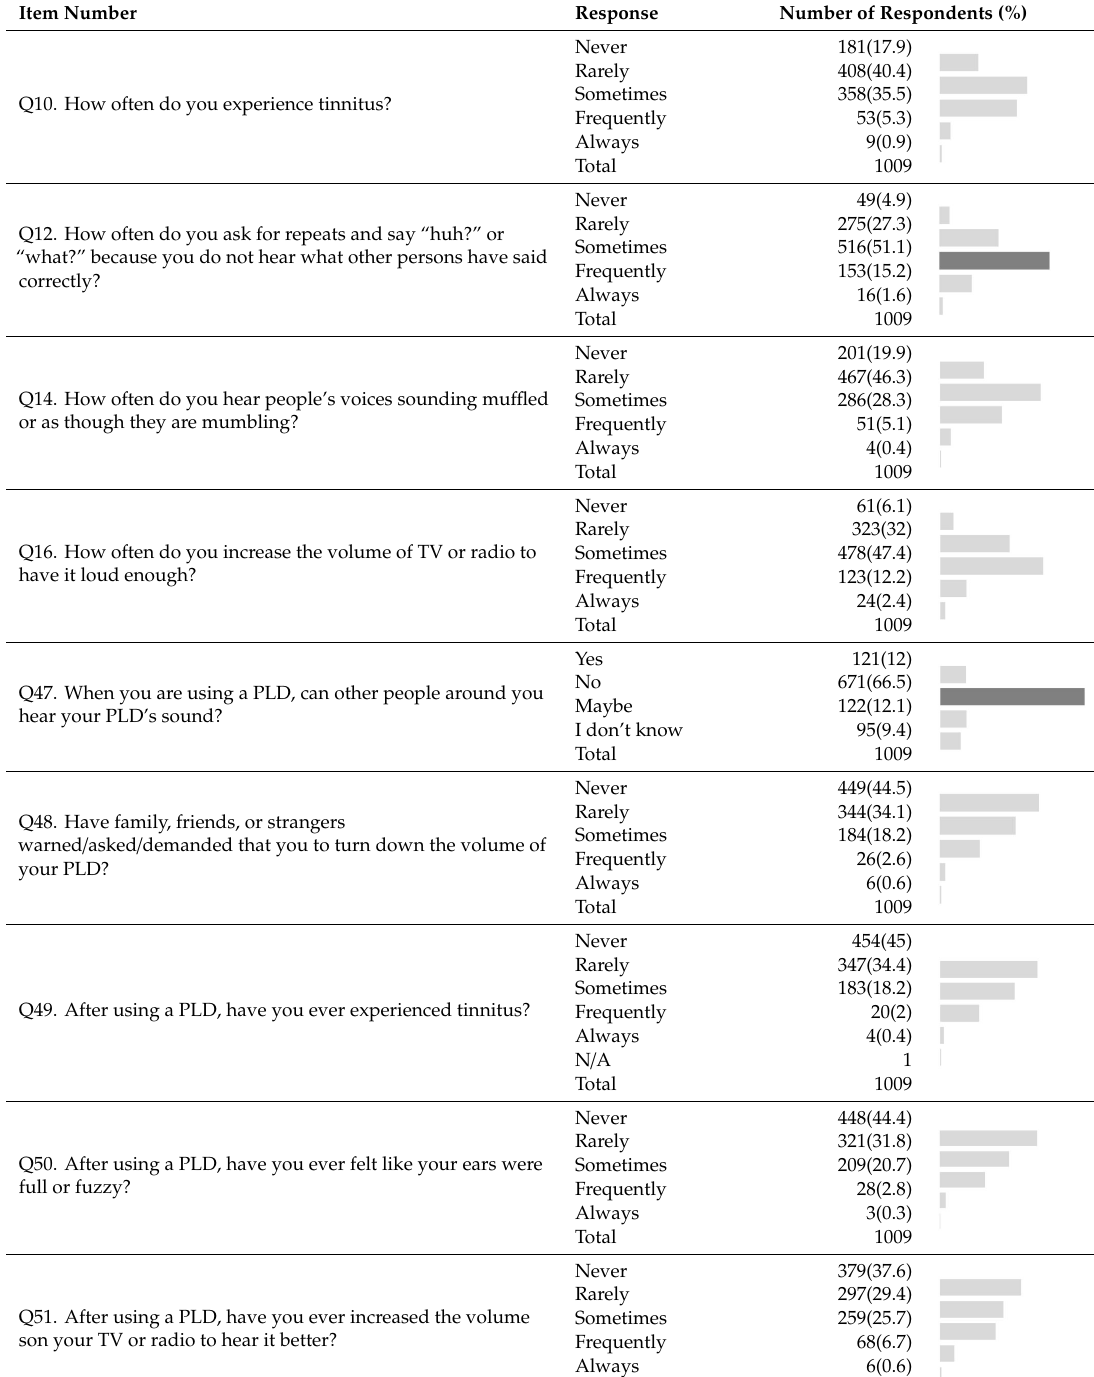
Table A6. E ff ects on hearing from PLD